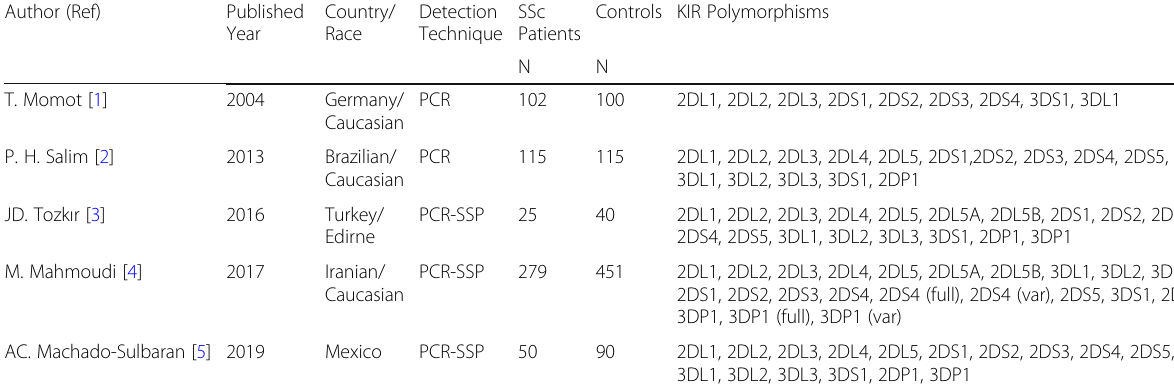
Table 1 Specifications of the included studies in this